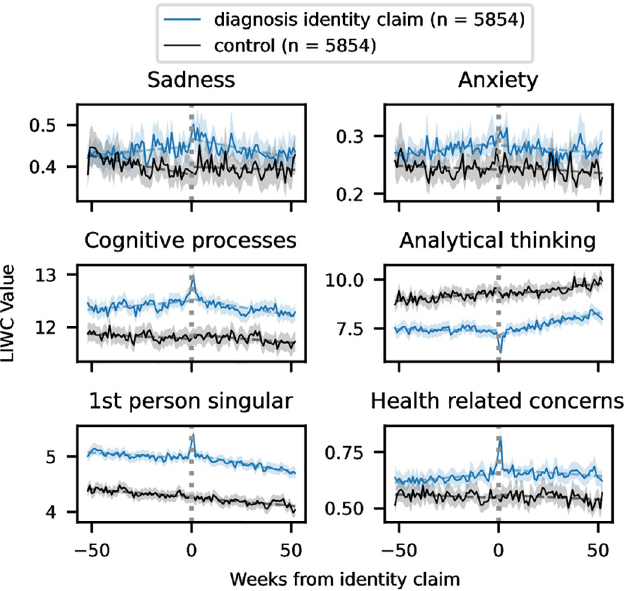
Fig 1. LIWC changes over time for users with a diagnosis identity claim and controls. Analytical thinking is computed based on other categories; the other y axes are percentage of total words. The solid line marks the weekly mean values; the dashed line shows the trend lines for the before and after periods, and the shaded area covers the 95% confidence interval.